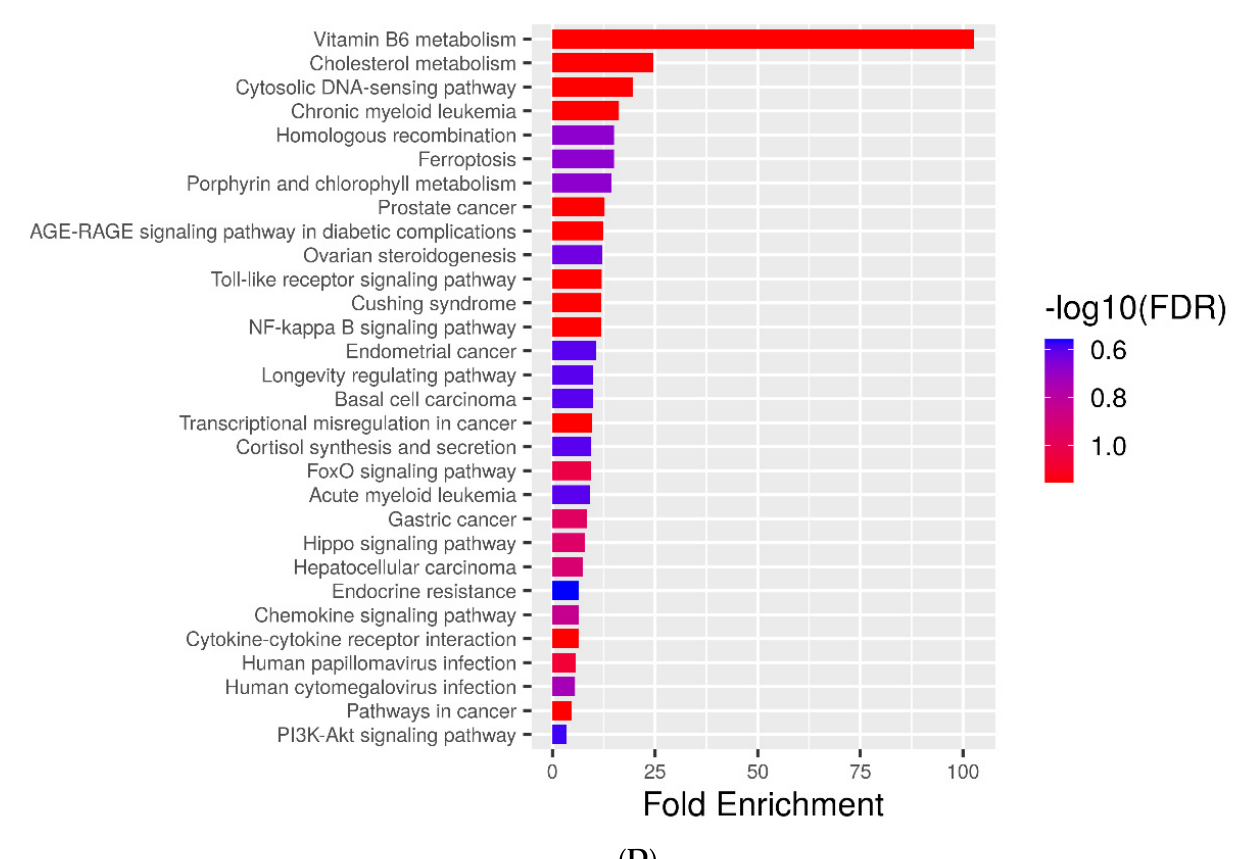
Figure 3. KEGG pathway enrichment analysis of genes encoding ( A , C ) AFP 14–20 -like motif-containing proteins and ( B , D ) GIP-9-like motif-containing proteins. Rankings by both number of genes ( A , B ) and fold enrichment value ( C , D ) are shown. Bar plot representation with an aspect ratio of 1.5 and − log10 (FDR) heat maps for each category are shown.